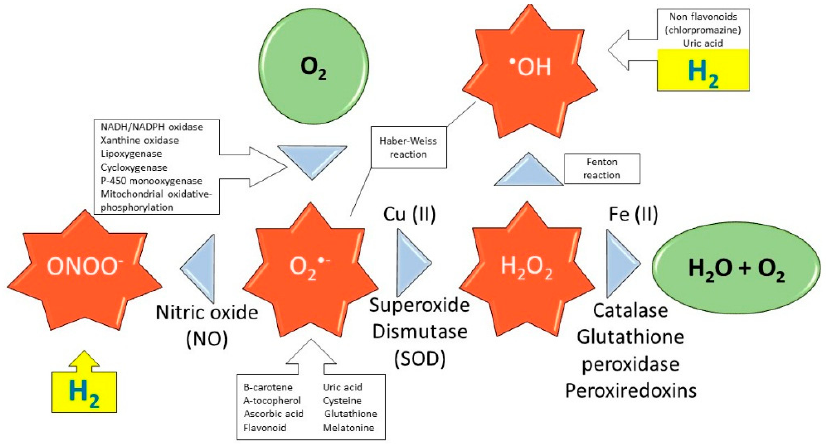
Figure 1. Production of ROS: effect of antioxidants and selective action of H 2 . Schematic reactions of ROS production by action of enzymes during respiration in mitochondria. Green color represents non-radical molecules, red color represents ROS created from normal respiration, yellow color indicates action of H 2 .